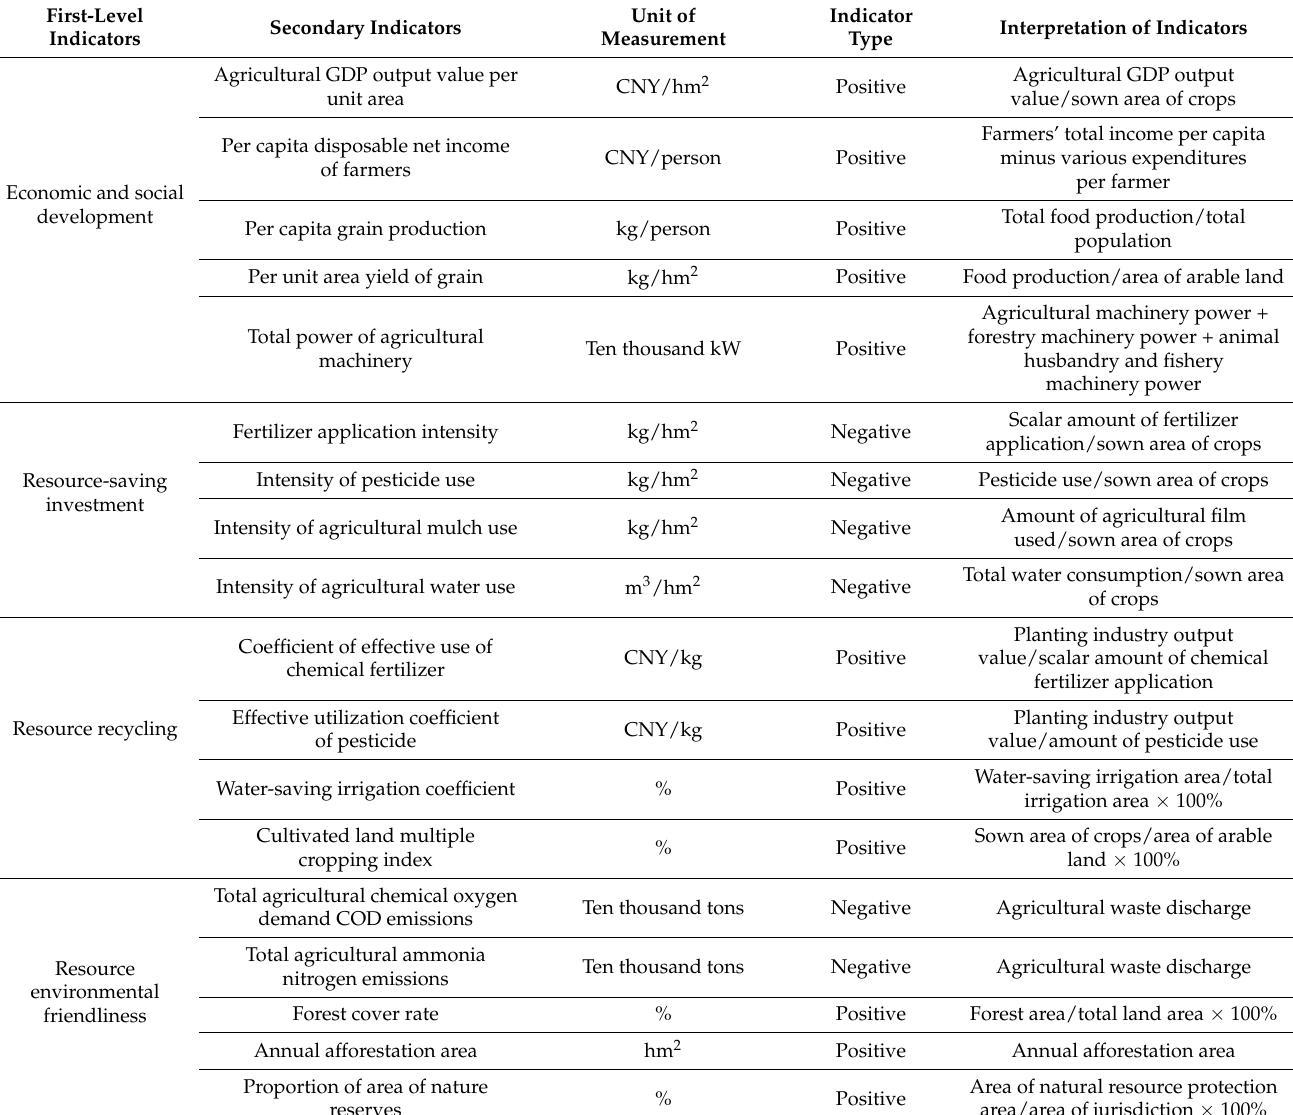
Table 1. Indicator system for measuring the development level of green